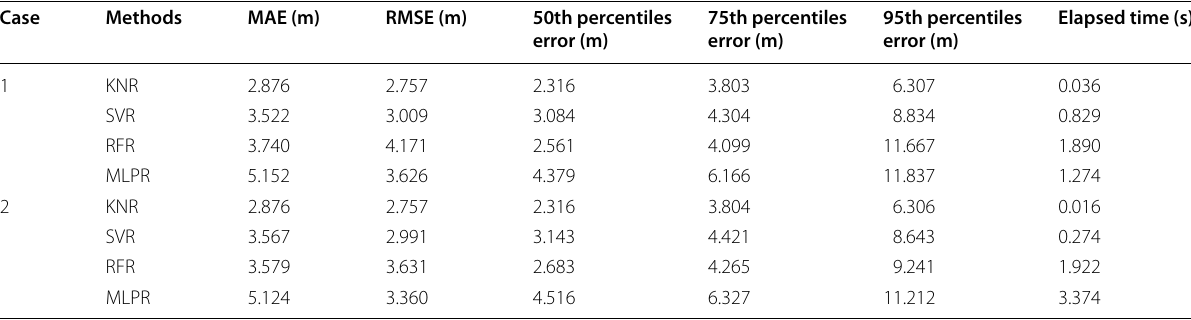
Table 13 Statistics of regression methods based on the training sheet in the CETC331 building Case